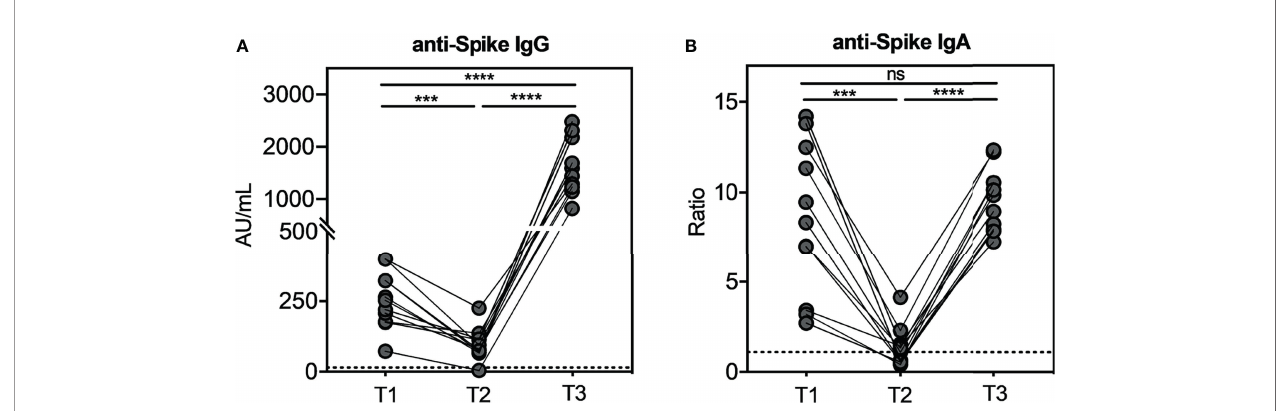
FIGURE 1 | Kinetic of total anti-SARS-CoV-2 IgG and IgA serum antibodies levels in seronegative recipients (ICs n=11) of P fi zer-BioNTech BNT162b2 mRNA-based vaccination. The evaluation of both serum antibodies was conducted at three weeks (T1) and nine months (T2) after the second dose, and three weeks after the booster dose (T3). In Figure (A) anti-SARS-CoV-2 S1/S2 IgG levels and in (B) anti-SARS-CoV-2 S1 IgA levels. The dotted lines correspond to IgG (> 15.0 AU/mL) and IgA (>1.1 Ratio) cut-off, respectively. The signi fi cance was determined using Tukey ’ s multiple comparisons test. One-way ANOVA, ***p=0.0002; ****p<0.0001, ns, not signi fi